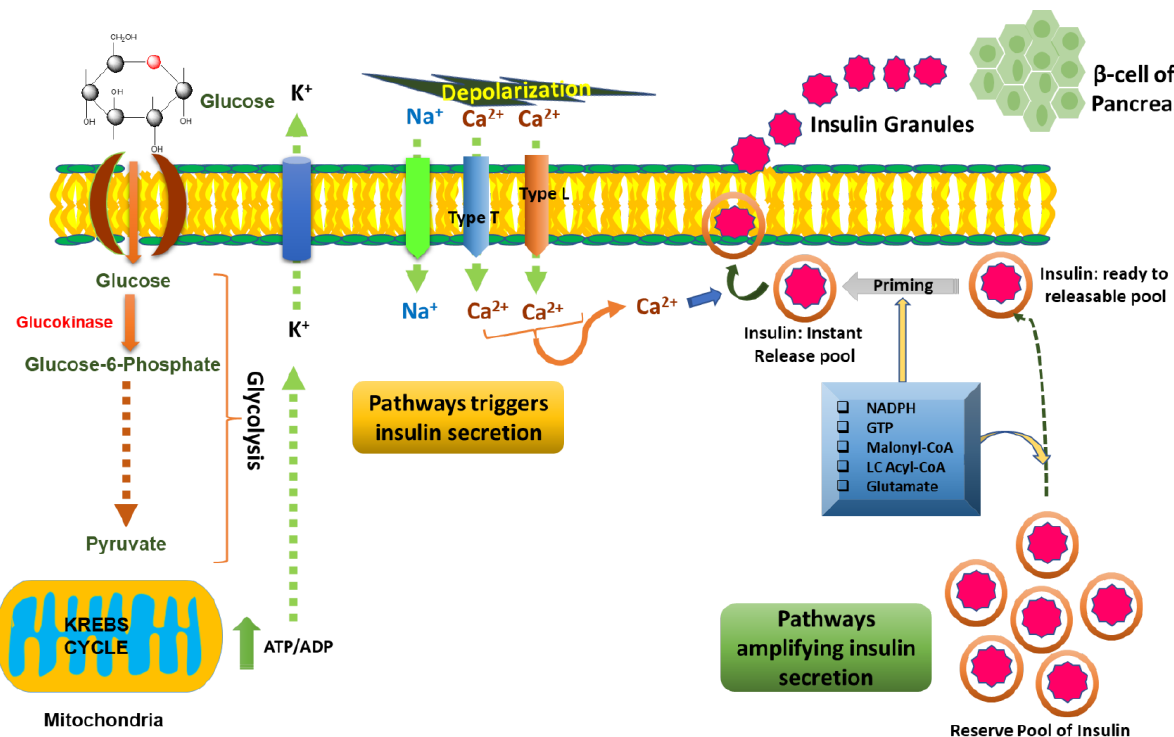
Figure 6. Pathways and mechanism of biphasic glucose-induced insulin secretion in the cell. Unquestionably, insulin secretion is caused by pancreatic β -cells in response to ele- vated levels of nutrients (predominantly glucose) in the blood, and a number of signaling pathways are involved in it; however, these cells are very sensitive towards free radical species. The reason behind this sensitivity is the inefficient enzymatic antioxidant defensive system in pancreatic β -cells in comparison to other tissues such as liver tissue [120]. It is now established that hyperglycemia and oxidative stress are interlinked, and that ROS/RNS aid in diabetes progression. ROS aggravate the stress signaling pathways (NF- κ B) in β -cells of the pancreas which results in β -cell apoptosis [121]. Oxidative stress also inhibits the respiratory chain in pancreatic β -cells, leading to suppression of glucose-mediated insulin secretion via a reduction in ATP generation [122,123]. Interestingly, insulin gene expres- sion in pancreatic β -cells of db/db mice is modulated by oxidative stress by suppressing the level of the MafA and PDX-1 transcription factors [124]. Hyperglycemia also leads to excessive mitochondrial metabolism in β -cells, leading to alterations in the mitochon- drial shape, volume and behavior as well as K-ATP channels, thus causing obstruction in glucose-mediated insulin secretion [125]. In spite of the numerous pieces of evidence of the close association of ROS and diabetes, the role of OS in the progression of diabetes is still enigmatic and skeptical, which needs to be further